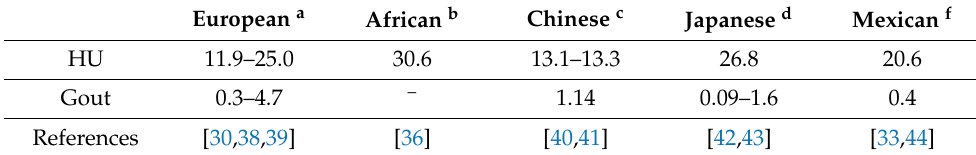
Table 5. Prevalence (%) of hyperuricemia and gout across non-U.S.